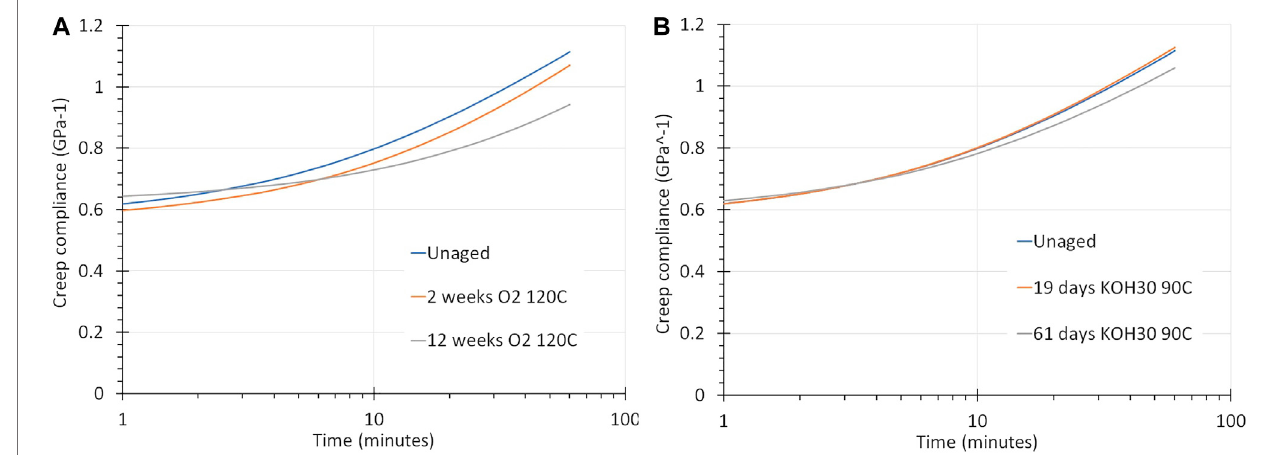
FIGURE 10 | (A) Creep compliance of PSU and PSU aged in oxygen at 5 bar and 120 ° C for 2 and 12 weeks. The curves are given for a creep-recovery measurement at 150 ° C at a stress of 5 MPa, for 1 h. PSU becomes to some degree less compliant. (B) Creep of PSU and PSU aged in a 30 wt% KOH solution at 90 ° C for 19 and 61 days, measured by creep-recovery at 150 ° C at a stress of 5 MPa for 1 h. The compliance is less affected than after an O 2 exposure.